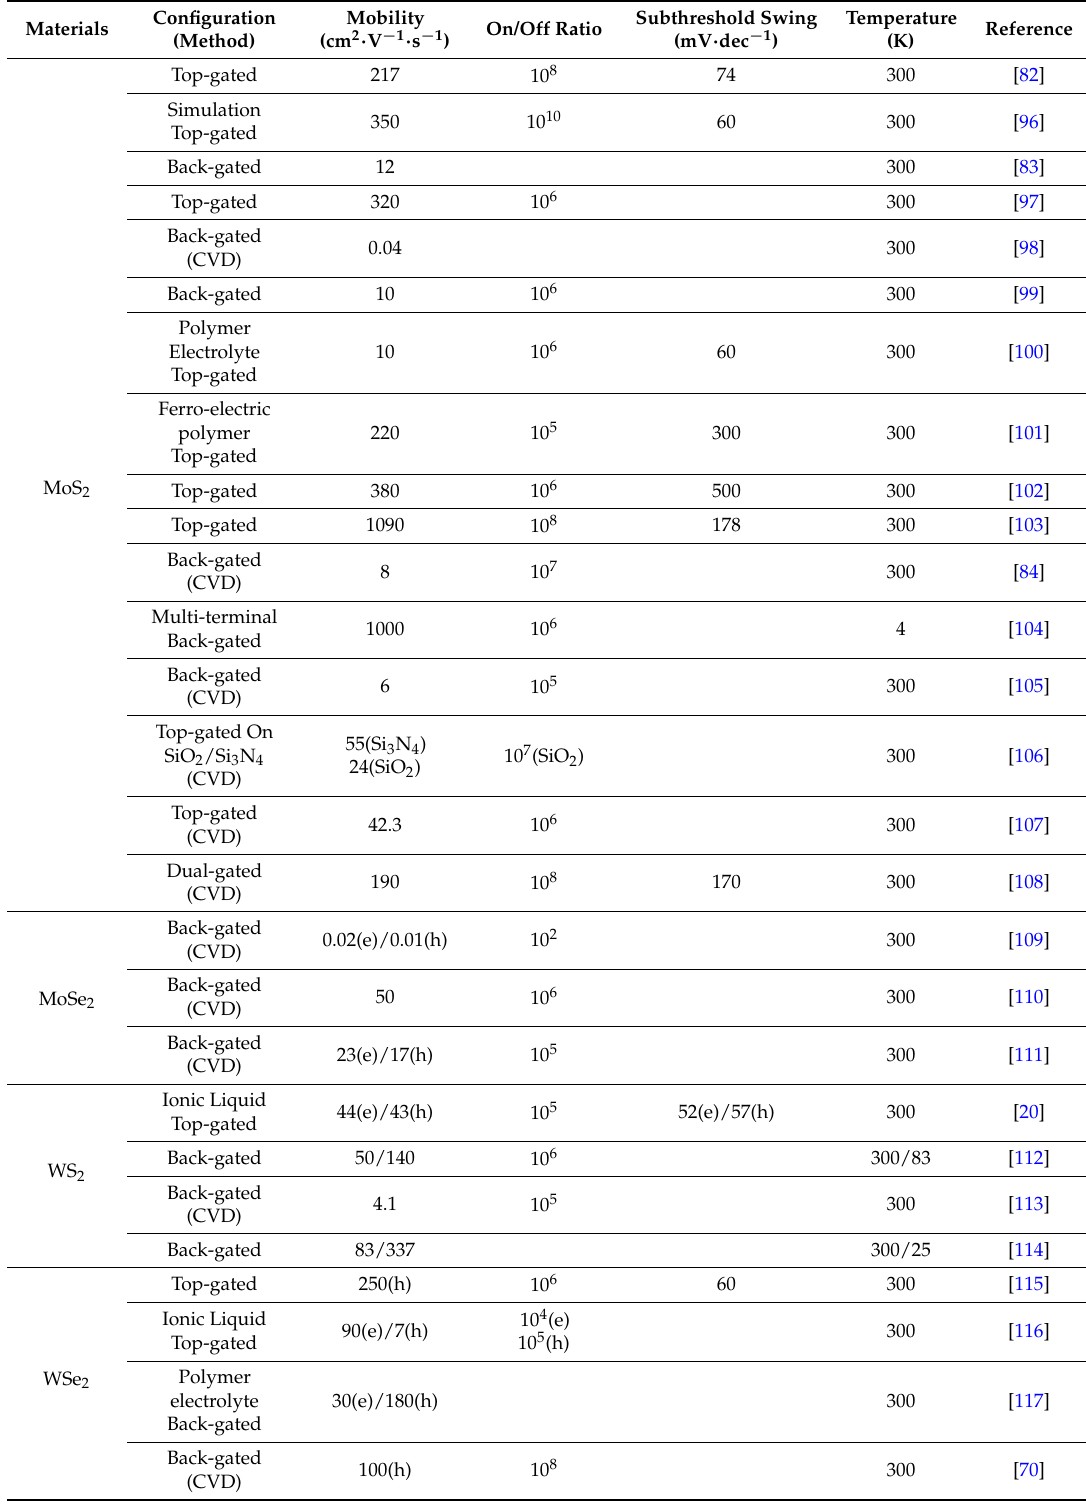
Table 3. Performance of FETs based on monolayer, exfoliated TMDCs, and CVD TMDCs. Electron mobility is compiled here (or denoted by e). The hole mobility is denoted by